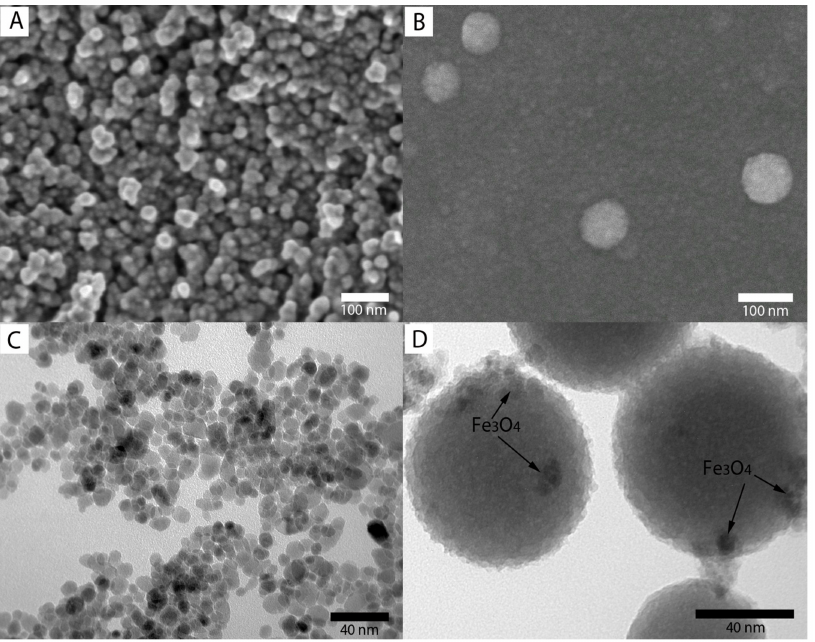
Figure 4. SEM images of Fe 3 O 4 MNPs ( A ) and Fe 3 O 4 @SiO 2 MNPs ( B ); TEM images of Fe 3 O 4 ( C ) and Fe 3 O 4 @SiO 2 ( D ).